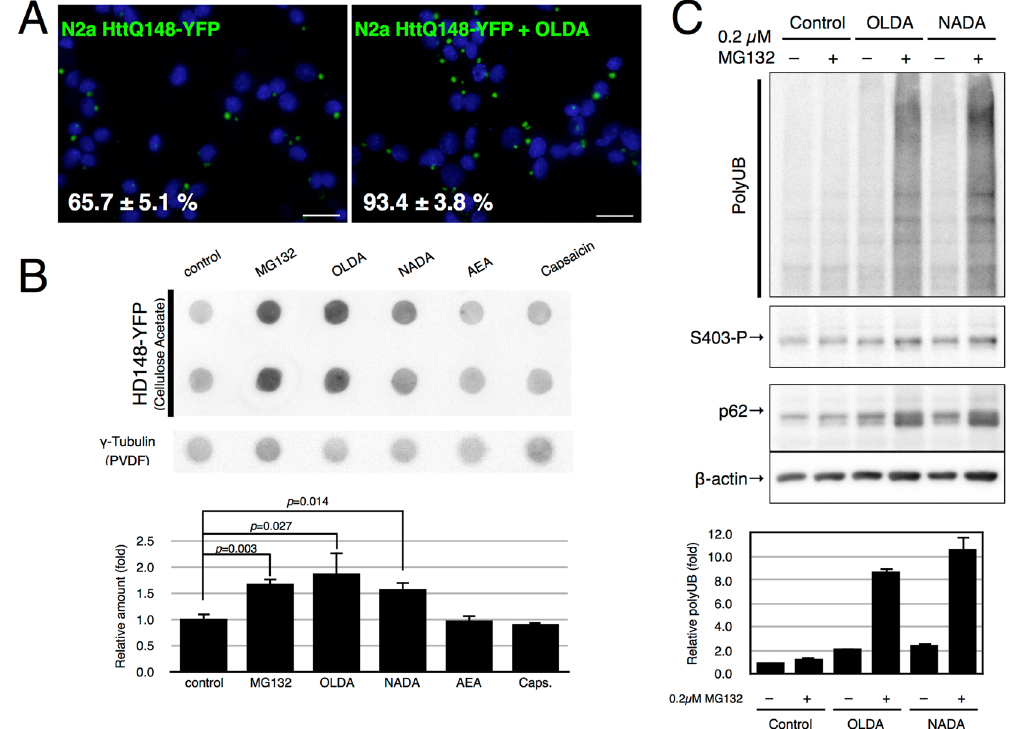
Figure 6. AcylDA accelerates huntingtin aggregation. ( A ) N2a cells stably expressing huntingtin-ex1-Q148- YFP (N2a HttQ148-YFP) were treated with 3 µ M OLDA for 3 days after Htt-YFP induction by doxycycline. Cells with Htt aggregates were counted (n > 100) and the number of aggregates was divided by the number of nuclei. ( B ) N2a HttQ148-YFP cells were treated with 5 µ M OLDA, 5 µ M NADA, 10 µ M AEA, 50 µ M capsaicin, or 1 µ M MG132 for 48 h as indicated. Htt aggregates were visualized with anti-GFP antibody by filter trap assay. As a sample control, dot blot of the same sample on the polyvinylidene fluoride membrane is shown. The relative amount of HttQ148-YFP is shown. Error bars represent SEM (n = 4) and p values (Student’s t- test) are shown. ( C ) N2a cells were treated with 0.2 µ M MG132 and/or 5 µ M OLDA or 5 µ M NADA for 12 h as indicated. Total ubiquitinated proteins (polyUb; monomer), S403-phospho-p62 (S403-P), total p62, and β -actin are shown as indicated. Relative amounts of polyubiquitinated proteins (polyUb) in duplicated analysis are depicted. Error bars represent SD (n =